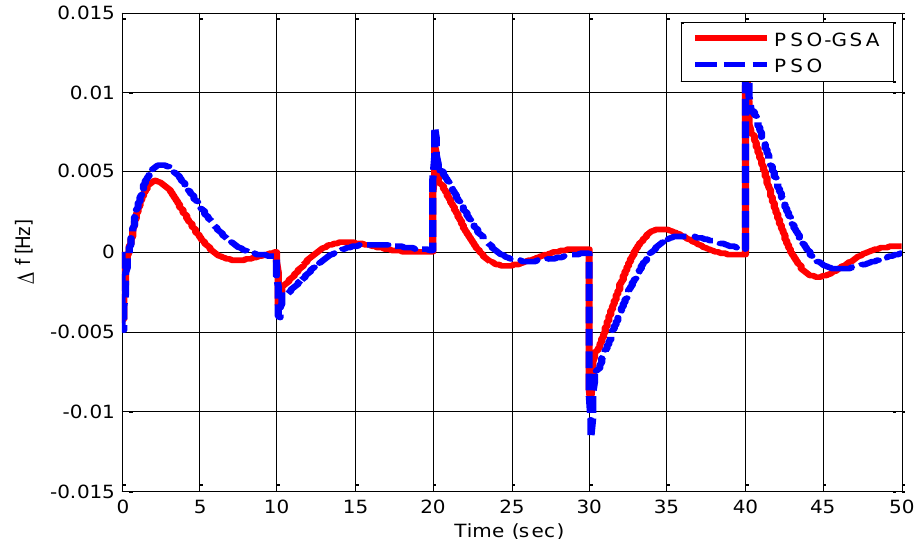
Figure 15. Stepped load changes applied to the studied system.